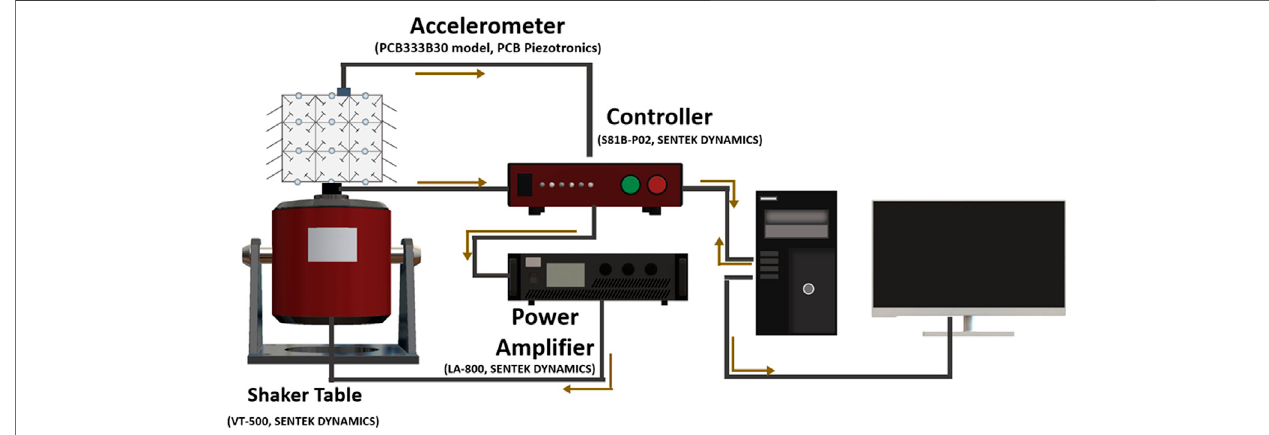
FIGURE 5 | Cartoon schematic of the experimental set-up used for measuring the transmissibility of the layered metamaterial vibration attenuation structure presented in this work.